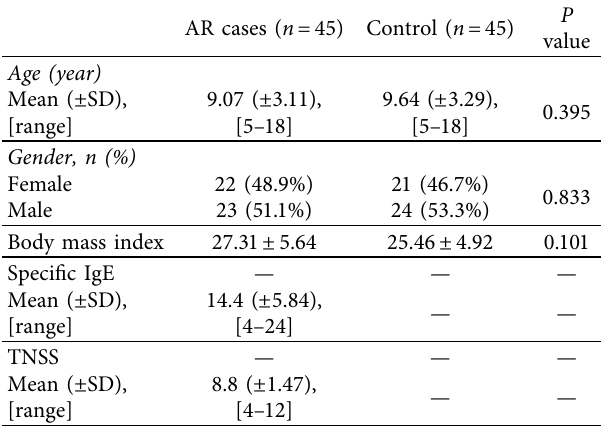
Table 1: Demographic data of the cases and